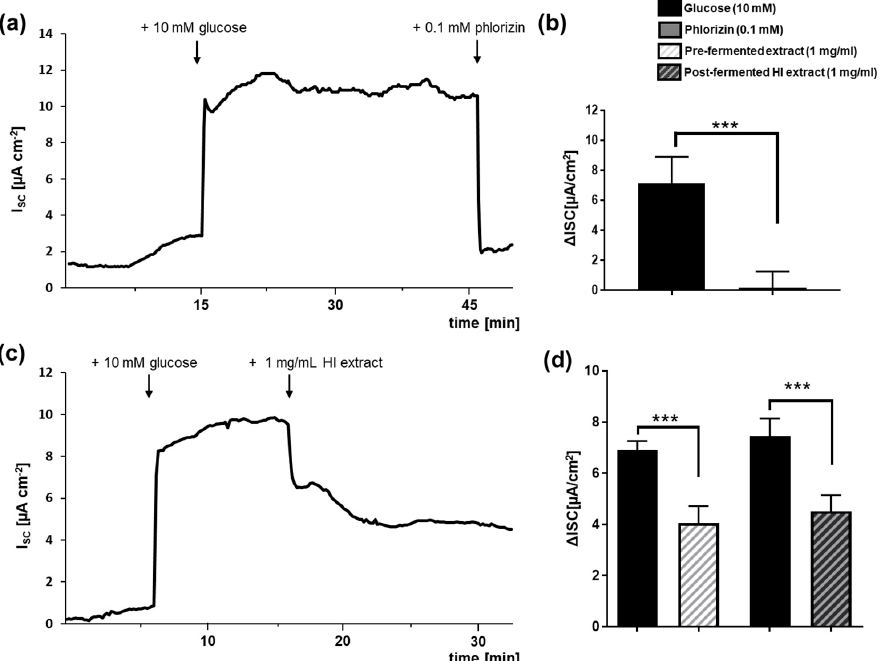
Figure 4. Influence of pre-fermented and HI-enriched post-fermented soy isoflavone extracts on sodium-dependent glucose transporter 1 (SGLT1). SGLT1-dependent glucose transport was measured in Caco-2/PD7 cell monolayers via Ussing chambers. Short-circuit current (I SC ) was followed over time (exemplary runs depicted in ( a , c )). After addition of 10 mM glucose to the apical side at the indicated time points, the I SC reached a stable plateau within approximately 10 min, before 0.1 mM phlorizin ( a ) as positive control or 1 mg/mL soy isoflavone extract ( c ) was added. The corresponding I SC values are shown in ( b , d ) and the I SC values for the pre-fermented extract are shown in ( d ). Error bars indicate standard deviation of n = 4–7 independent experiments. *** p < 0.001, unpaired t-test. HI: Hydroxy-isoflavone extract.